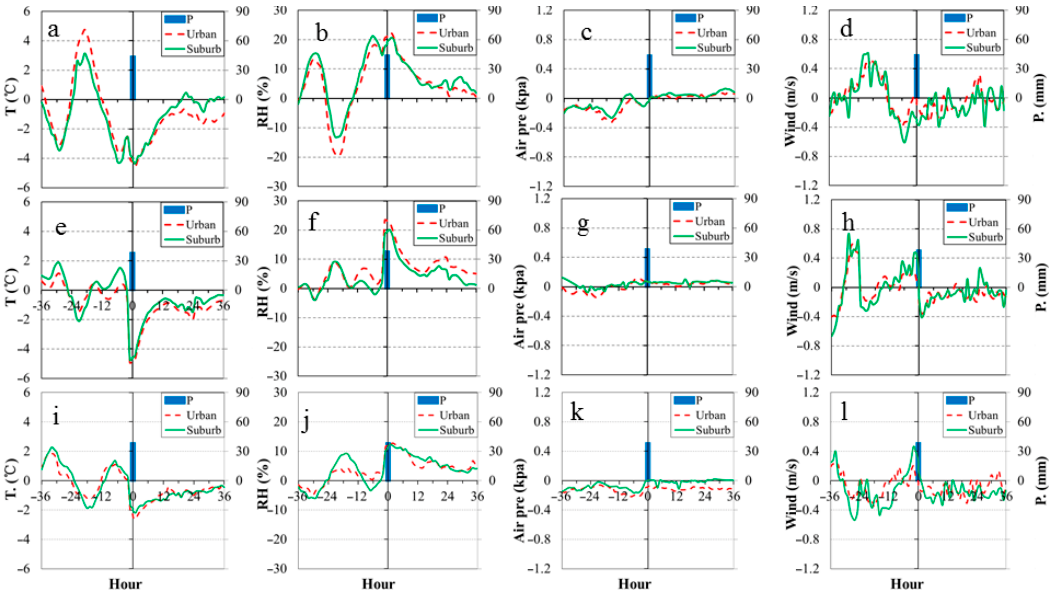
Figure 9. Anomalies of air temperature, relative humidity, surface pressure, and wind speed